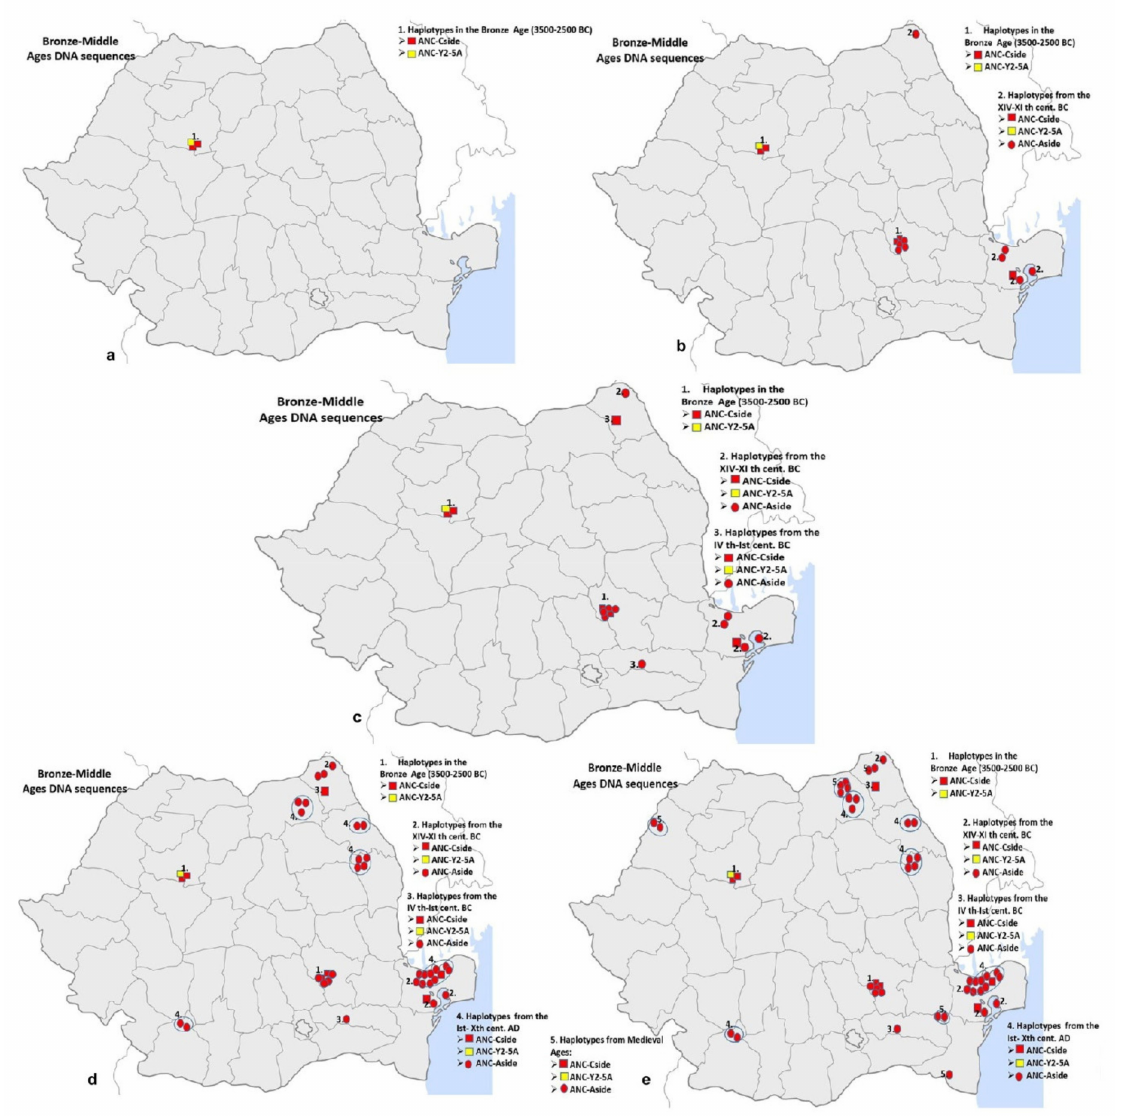
Figure 4. The prevalence of the European ANC-Aside haplotype on Romanian territory for the pig samples dating between the Early Bronze Age and Middle Ages: ( a ) Haplotypes’ spread between 3500–2500 BC; ( b ) Haplotypes’ spread between 3500-XIth century BC; ( c ) Haplotypes’ spread between 3500-Ist century BC; ( d ) Haplotypes’ spread between 3500 BC-Xth century AD; ( e ) Haplotypes’ spread between 3500 BC-Medieval